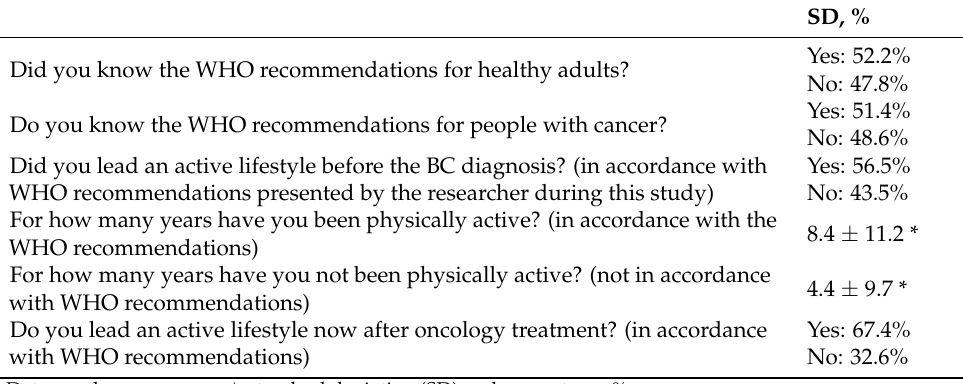
Table 2. Lifestyle of the BC women.